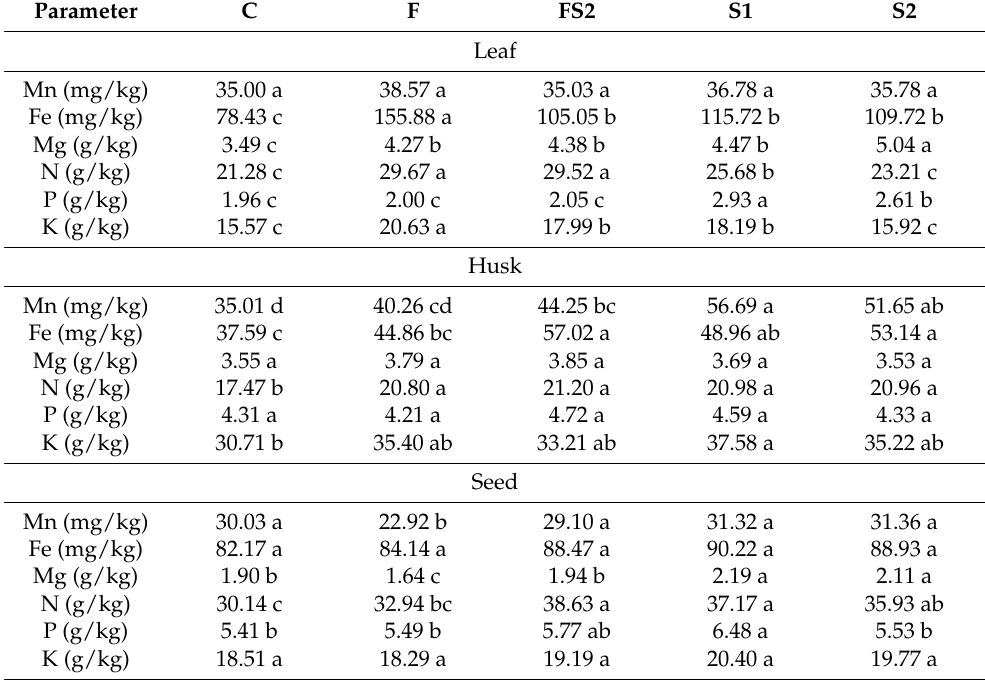
Table 2. Macro- and microelements in leaf, husk and seed of bean plants cultivated in: control soil (C—without EAF slag or NPK fertilizer), soil enriched with synthetic NPK fertilizer (F), soil enriched with a combination of 2% EAF slag and NPK fertilizer (FS2), and soil enriched with EAF slag (S1—at 1%, S2—at 2%